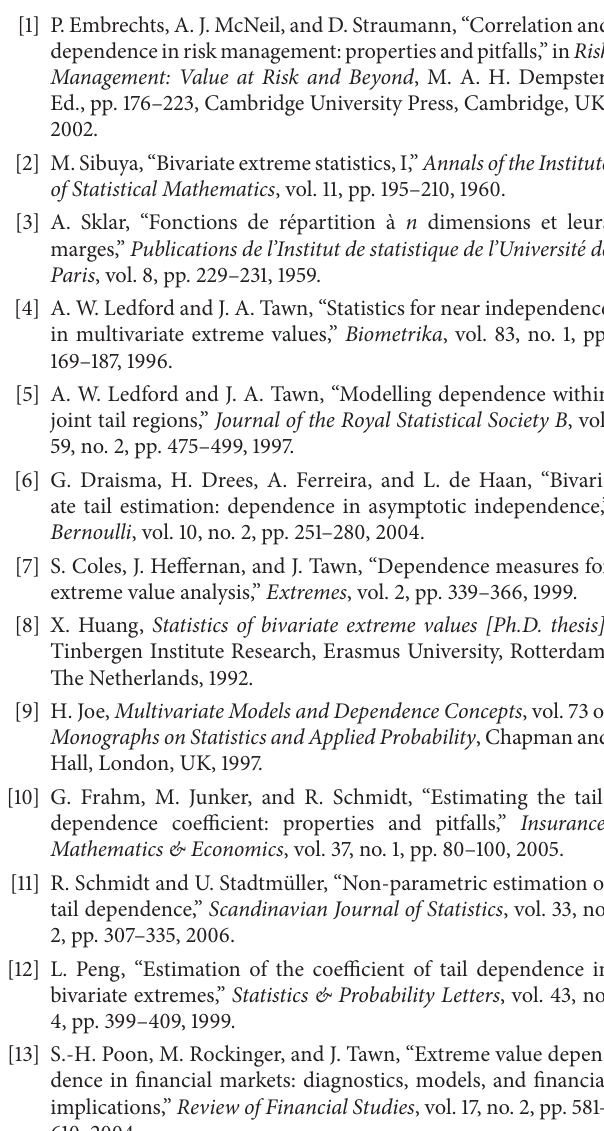
Table 5: Estimates of ̂𝜂, ̂𝜎 1 , ̂𝜎 2 ,